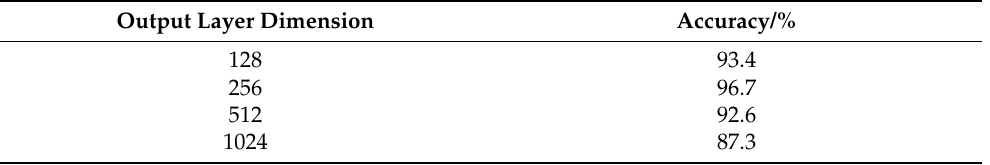
Table 8. Classification accuracy with different dimensions of the output